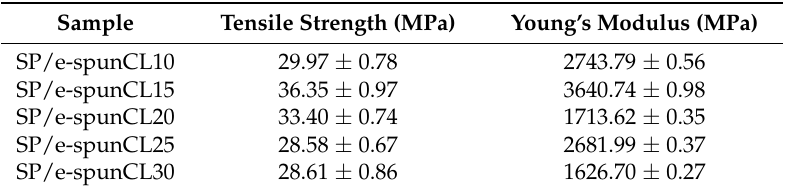
Table 5. The tensile properties of SP/e-spunCL